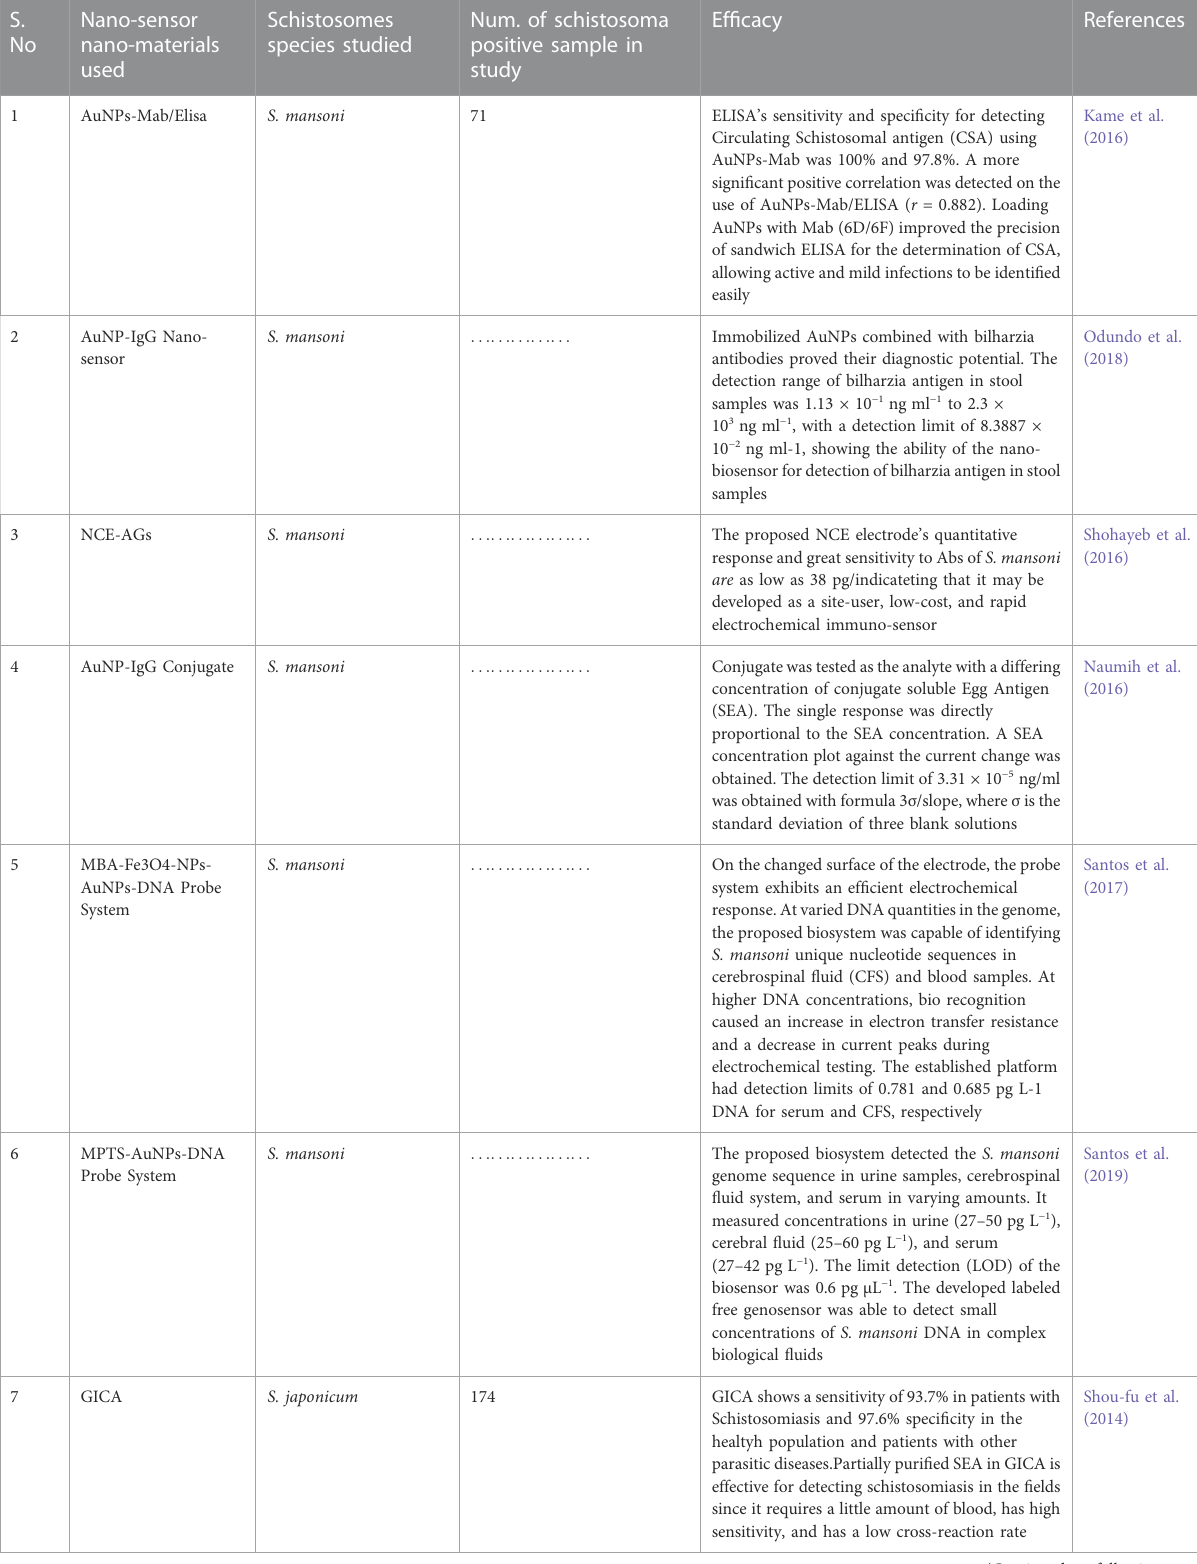
TABLE 3 List of Nano-sensor/Nano-material used in improving the diagnostic ability against schistosomal infections. S.